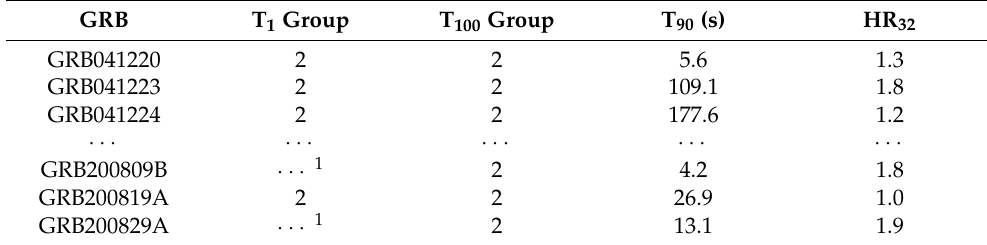
Table 2. Group membership of Swift GRBs, based on the analysis of the first second of prompt emission at 4ms resolution (T 1 ) and the T 100 interval at 64ms resolution. The full table is provided in the Supplementary Materials.